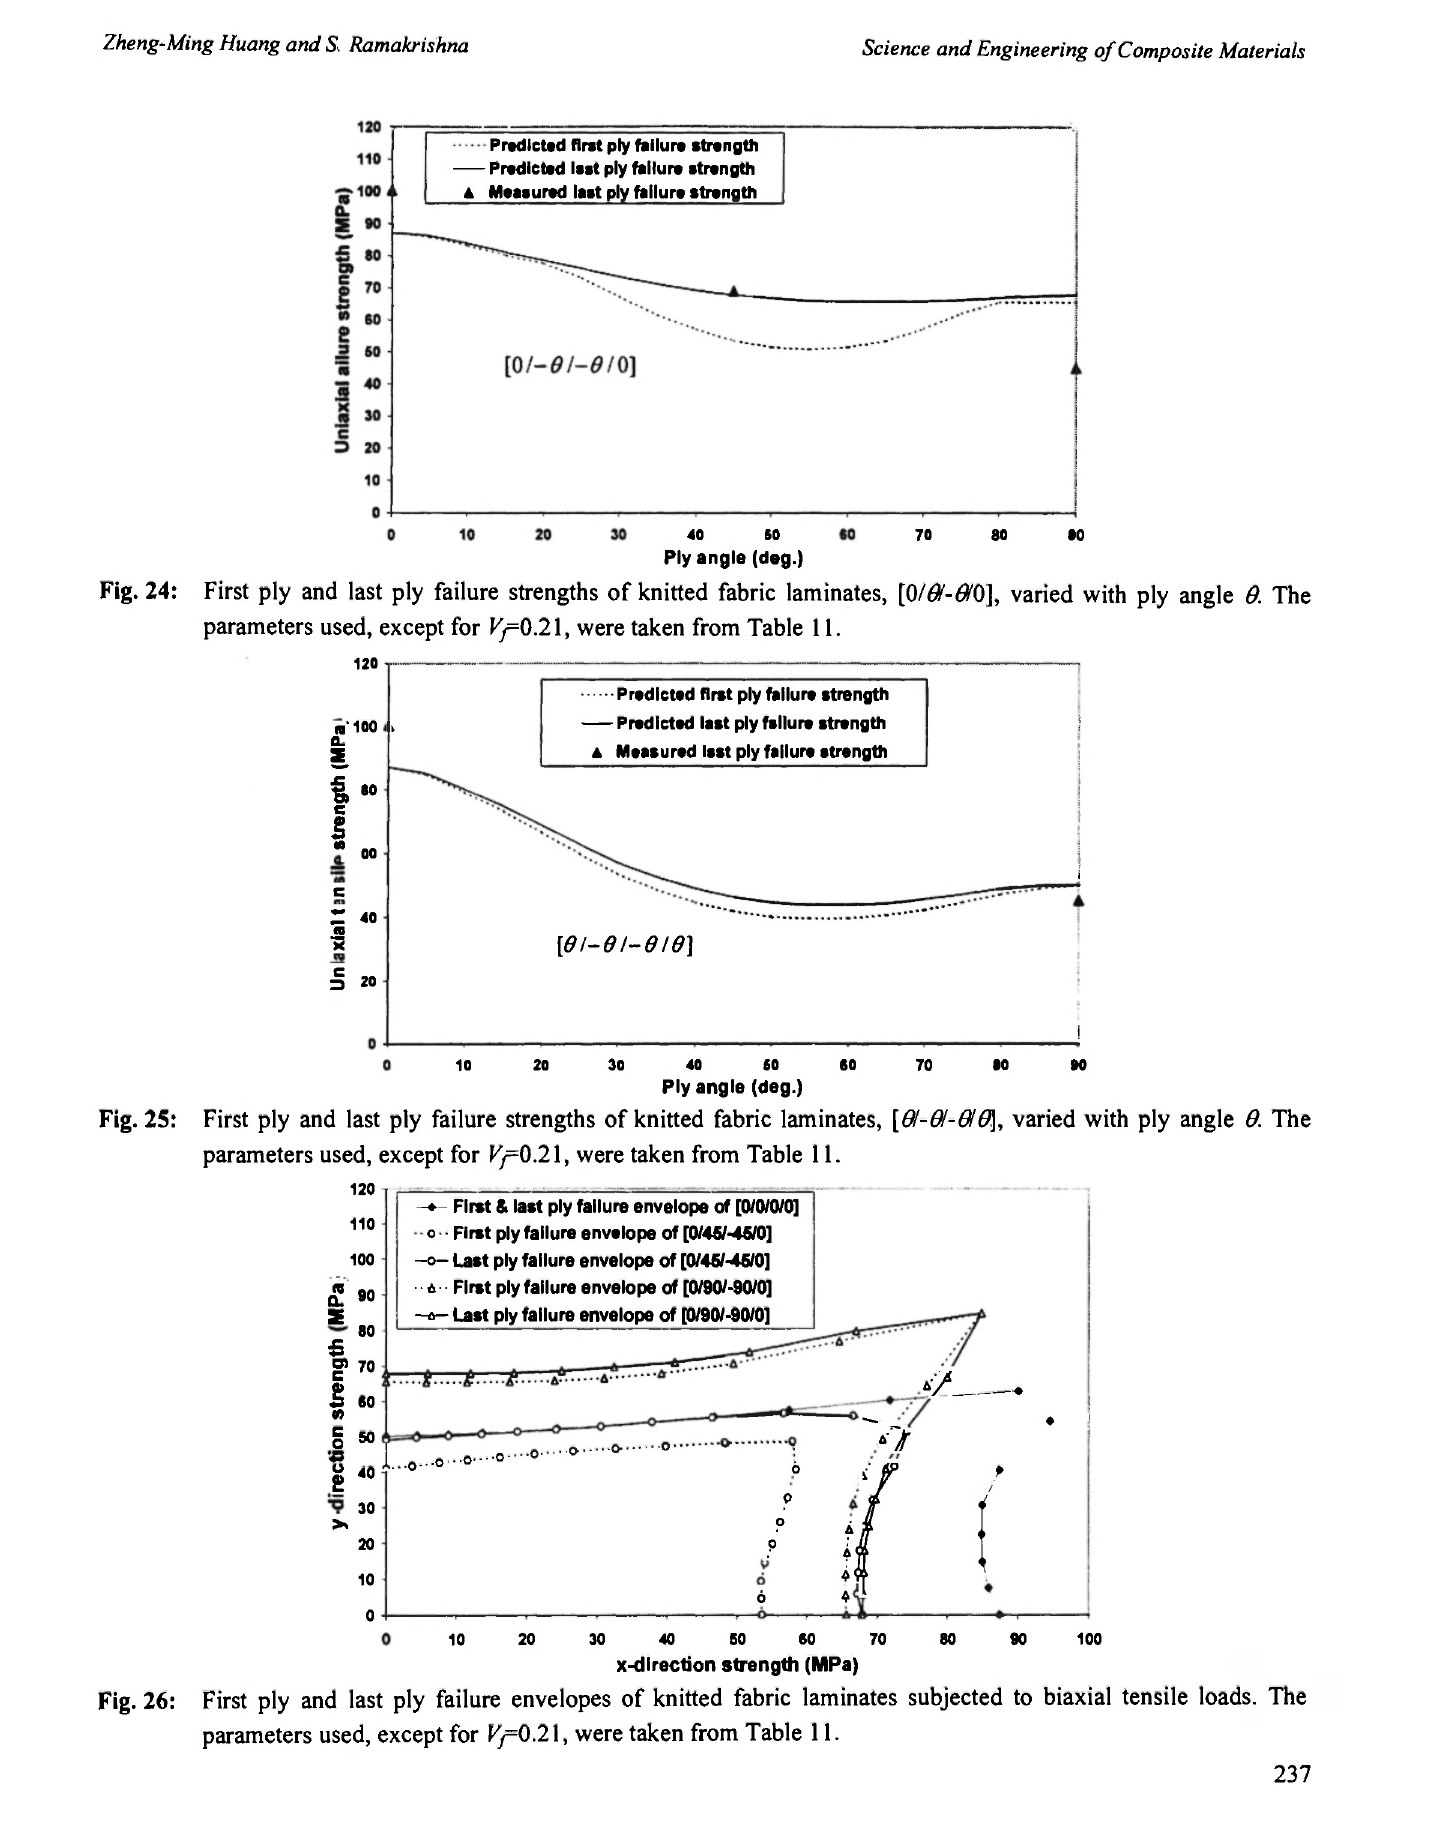
Fig. 26: First ply and last ply failure envelopes of knitted fabric laminates subjected to biaxial tensile loads. The parameters used, except for V/=0.2\, were taken from Table